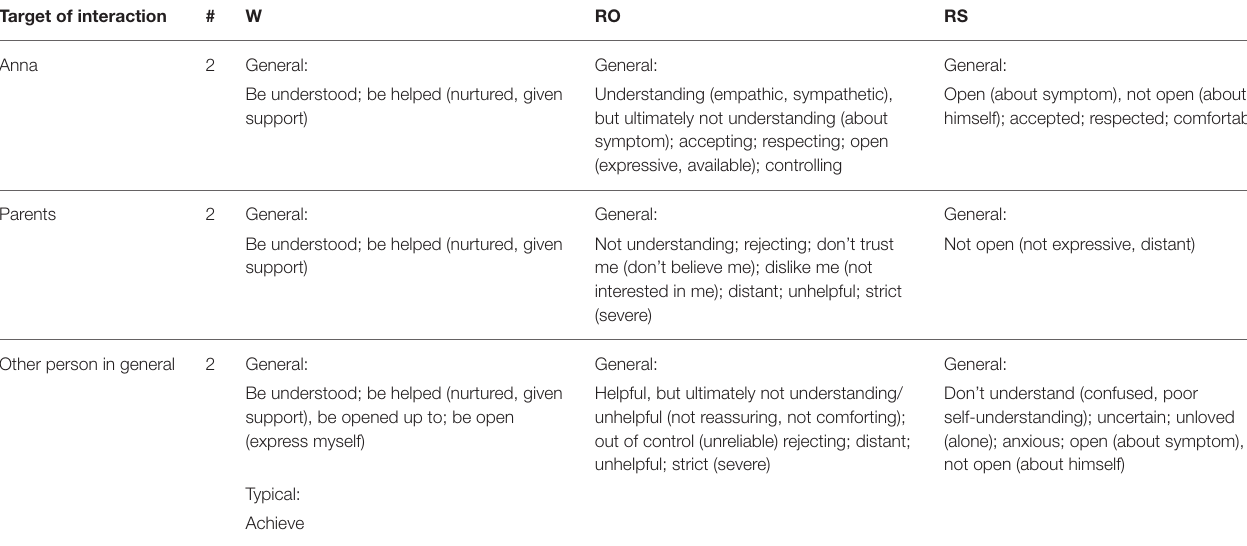
TABLE 1 | Patient’s wishes (W), responses of other (RO), and responses of self (RS) in sessions 1–4. Target of interaction